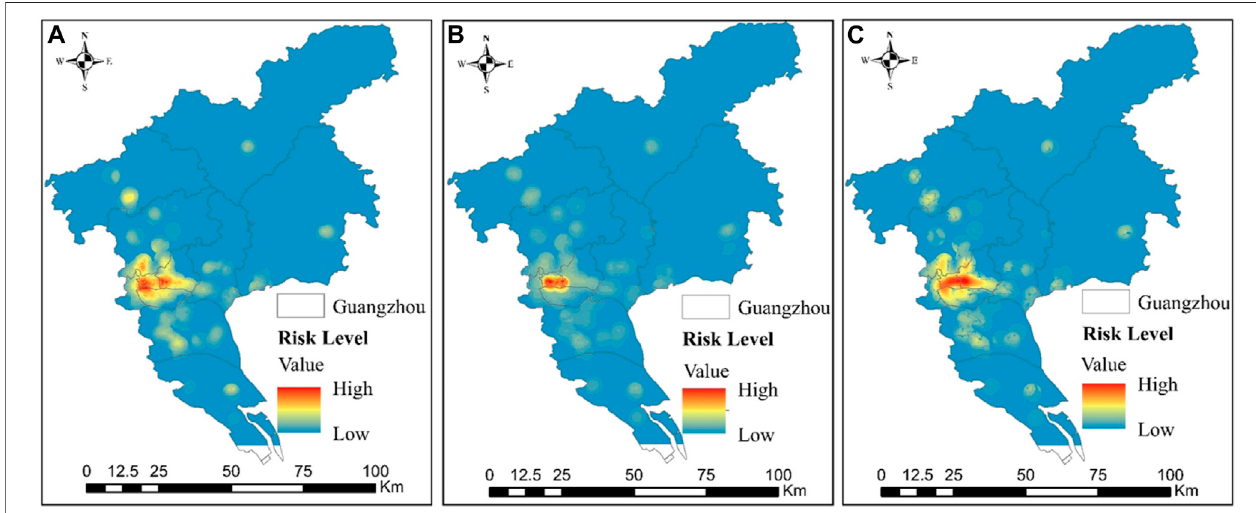
FIGURE 7 | Distribution map of the risk level of COVID-19 in (A) January, (B) February, and (C) August 2020 [ (A – C) are the high- and low-risk distributions of COVID-19 inGuangzhouinJanuary, February and August of2020,respectively. Thecolor inthe fi gure ranges from blue tored,indicatingthat therisklevel ofCOVID-19 ranges from low to high. In addition, the areas with high risk in January, February and August of 2020 are more concentrated].